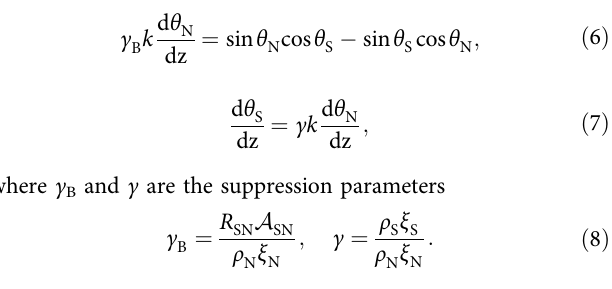
radius r S = R S / ξ S is smaller than λ S ⊥ = ; λ 2 = d Þ , where λ max ð λ S is the London penetration depth in S. S S S Equations (2) – (5) should be supplemented by the boundary